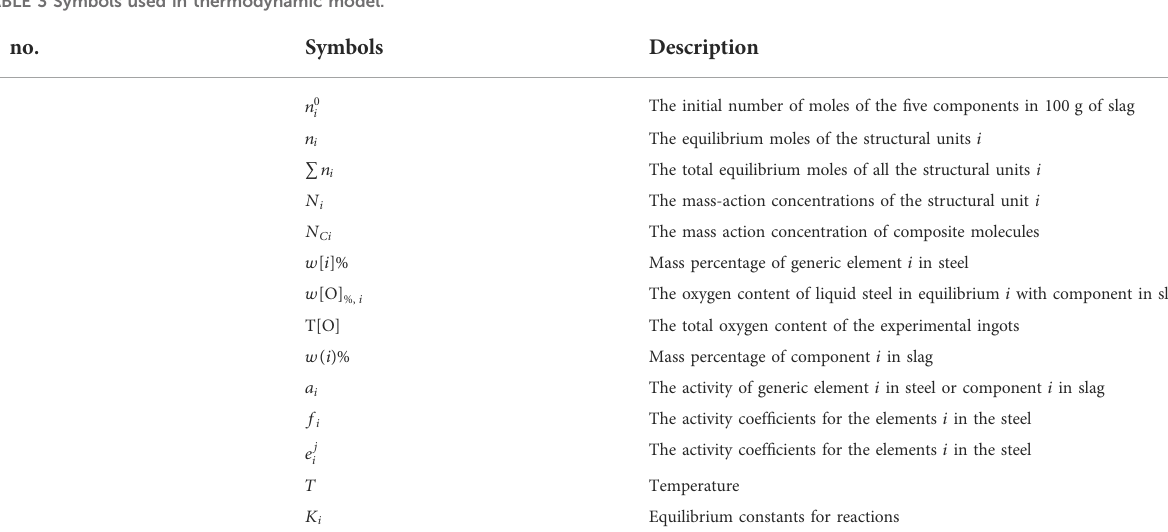
TABLE 3 Symbols used in thermodynamic model. S1